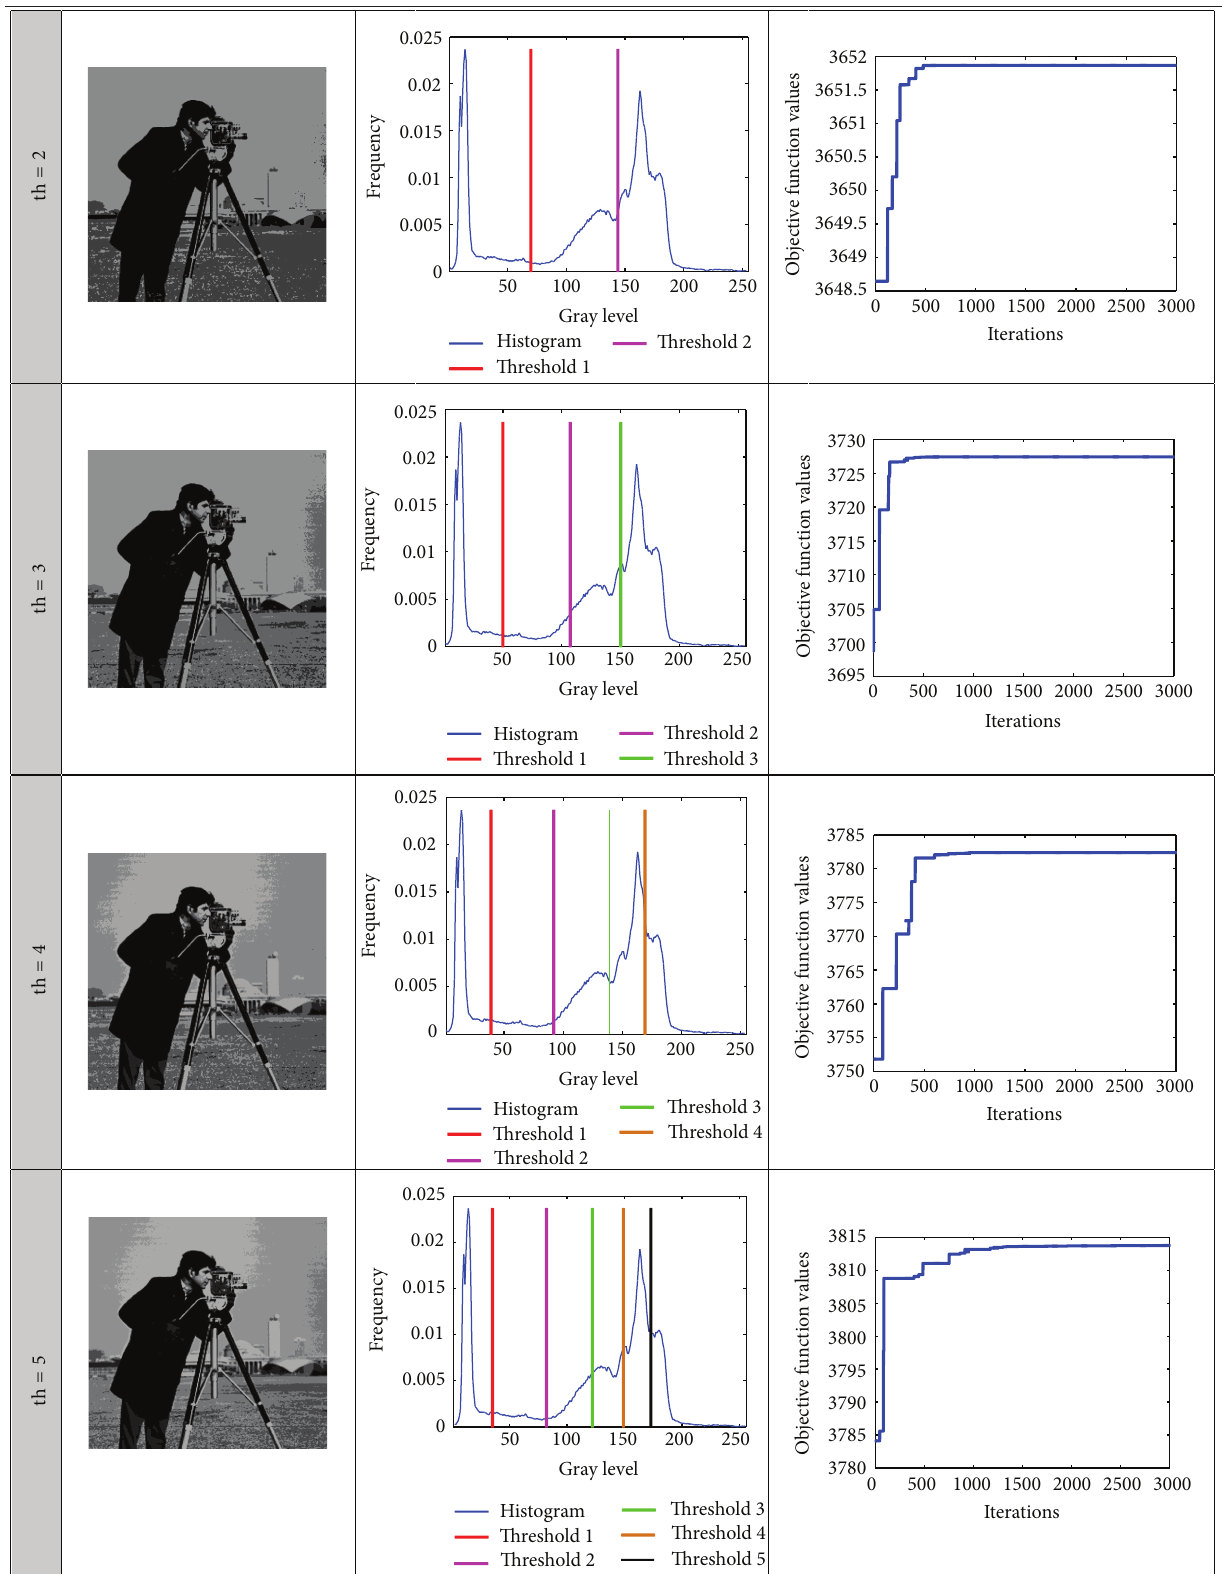
Table 4: Results after appling the HSMA using Otsu’s over the Camera man